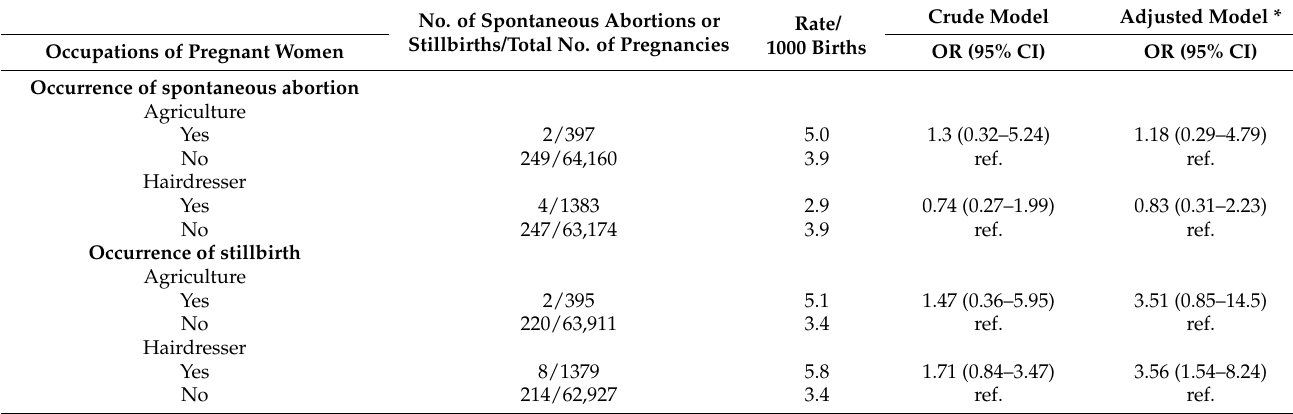
Table 5. Association between the occurrence of spontaneous abortion and stillbirths and exposure-related occupations among pregnant